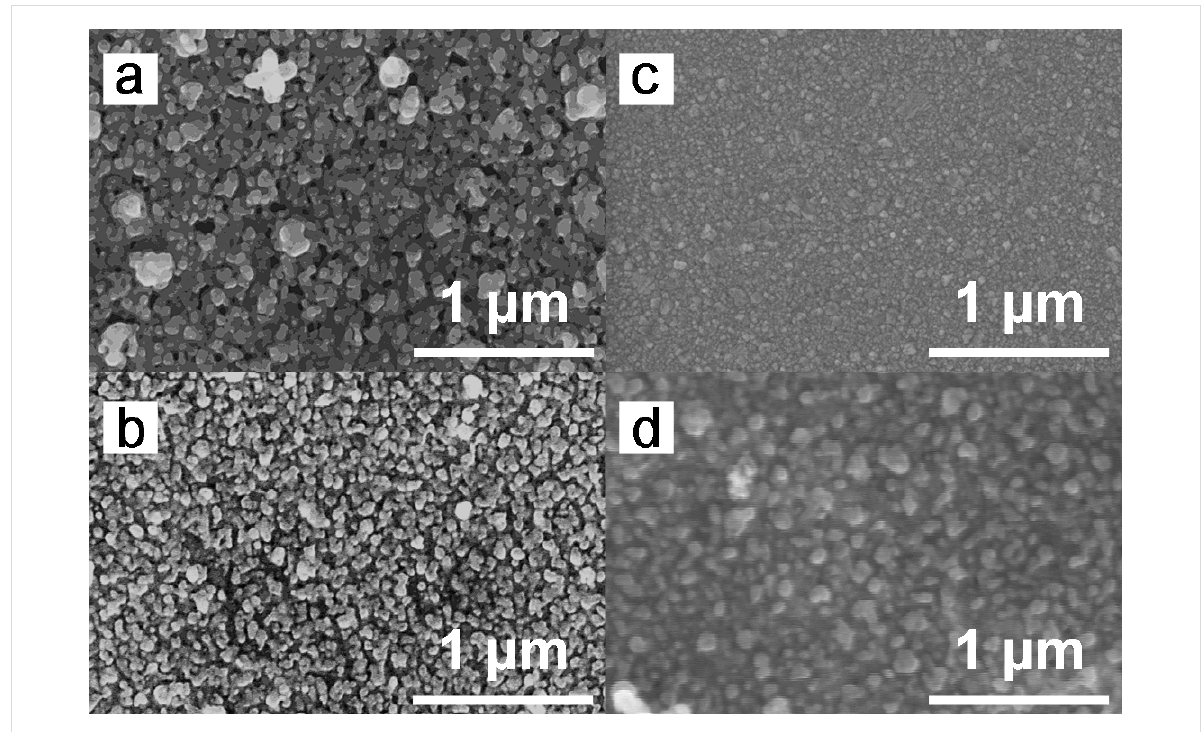
Figure 2: SEM images of mesoporous silver films after immersion for 40 min in NaBH 4 (a) without PVP and (b) with 5 mM of PVP, respectively. In (c) and (d) the micrographs of initial magnetron silver film and Ag 2 O films are presented.